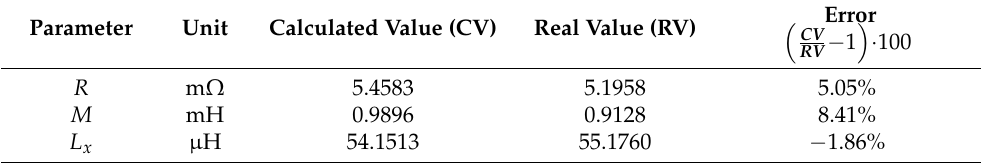
Table 4. The experimental results with two sinusoidal voltage test signals and measured